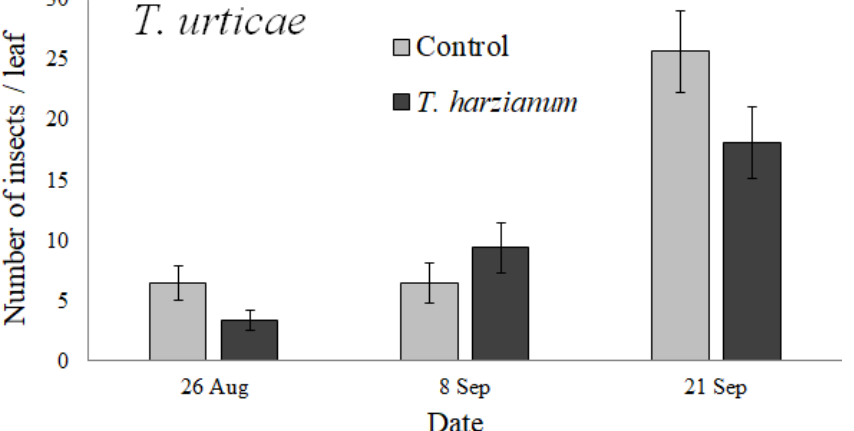
Figure 7. Mean values (± standard errors) of the abundance of Tetranychus urticae collected on tomato leaves during the experiment .